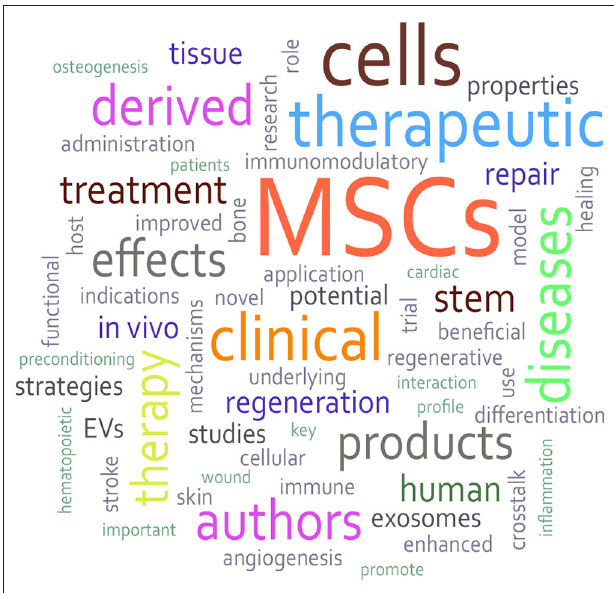
FIGURE 1 | Word cloud of the most frequent terms. This picture describes the most commonly used words in the Editorial on the Research Topic Mesenchymal Stromal Cell Therapy for Regenerative Medicine. Note that the size of the words is proportional to their